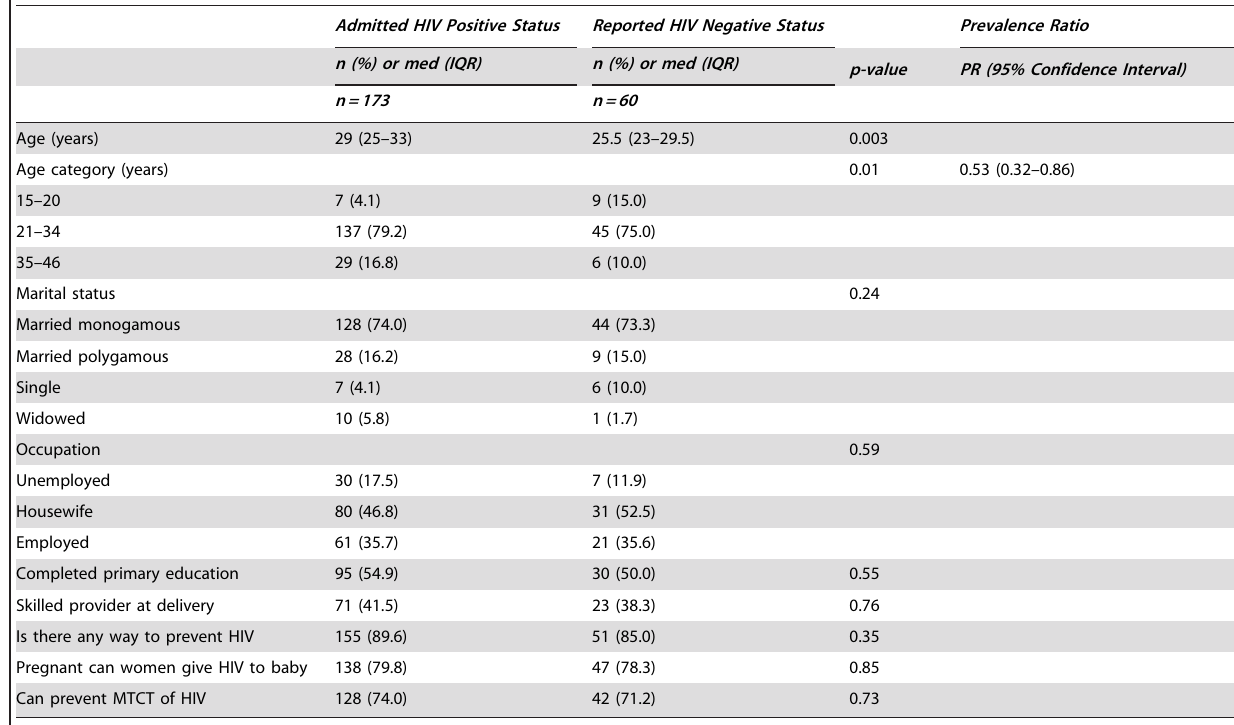
Table 5. Sensitivity